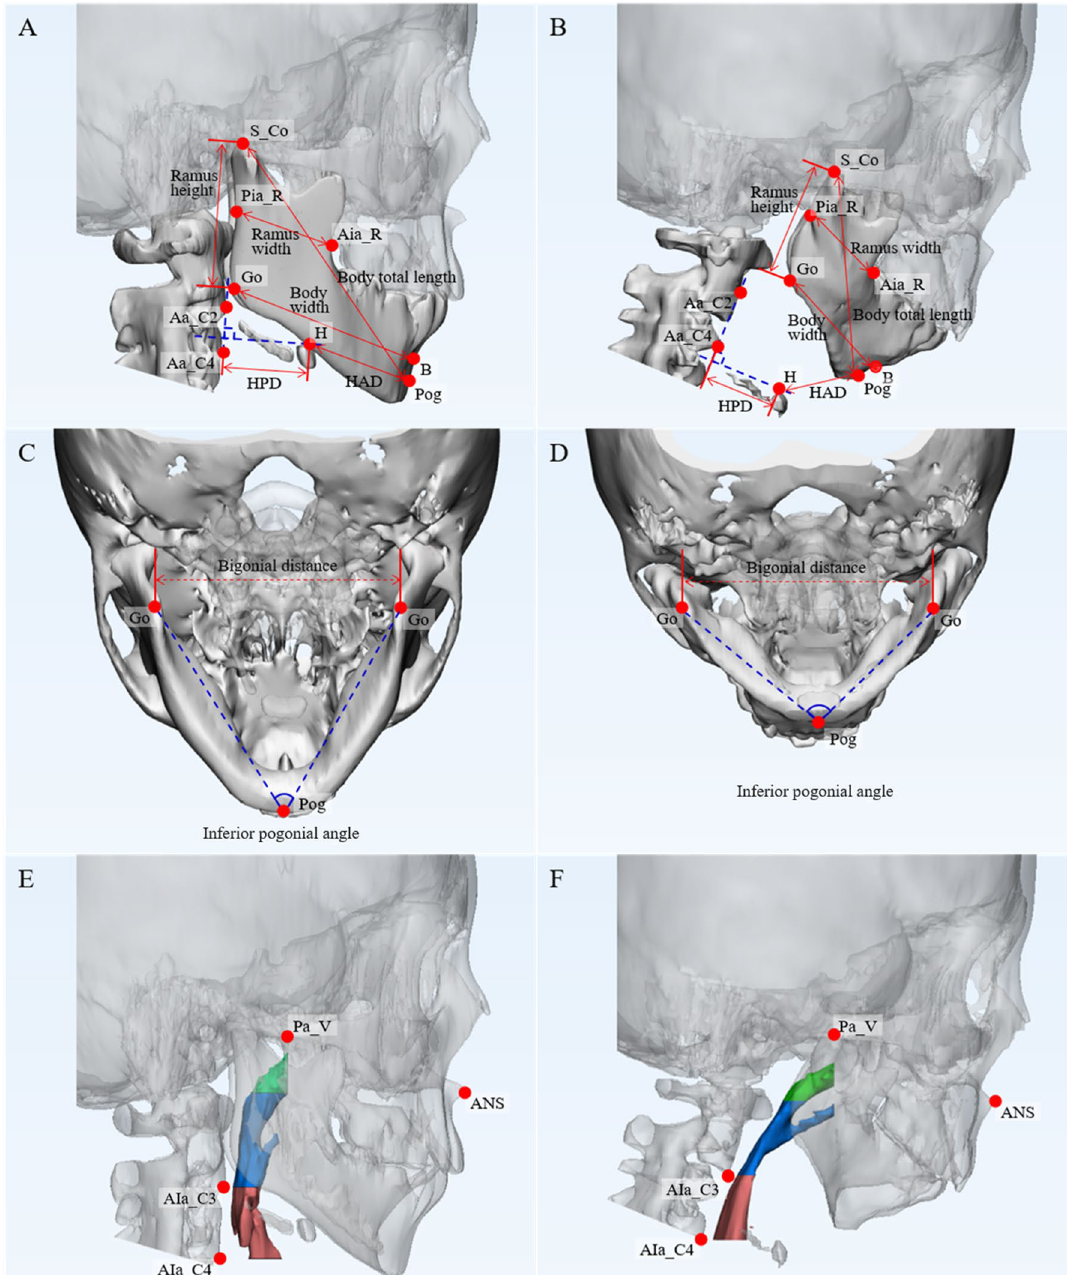
Figure 1. ( A ) Main variables of mandible measurement in the ramus, mandibular body, and position of the hyoid bone in healthy controls ( A ) and patients with mandibular hypoplasia ( B ). S_Co Superior condylion, Pia Posterior inner aspect of the ramus, Aia Anterior inner aspect of the ramus, Go Gonion, Pog Pogonion, Aa_C2 Anterior aspect of C2, Aa_C3 Anterior aspect of C3, HAD Hyoid anterior distance, HPD Hyoid posterior distance. Bigonial distance and inferior pogonial angle in healthy controls ( C ) and patients with mandibular hypoplasia ( D ). Upper airway volumes in healthy controls ( E ) and patients with mandibular hypoplasia ( F ). Green, blue, and red highlights indicate the nasopharynx, oropharynx, and hypopharynx, respectively. Pa_V Posterior aspect of vomer, ANS Anterior nasal spine, AIa_C2 Anterior inferior aspect of C2, AIa_C4 Anterior inferior aspect of